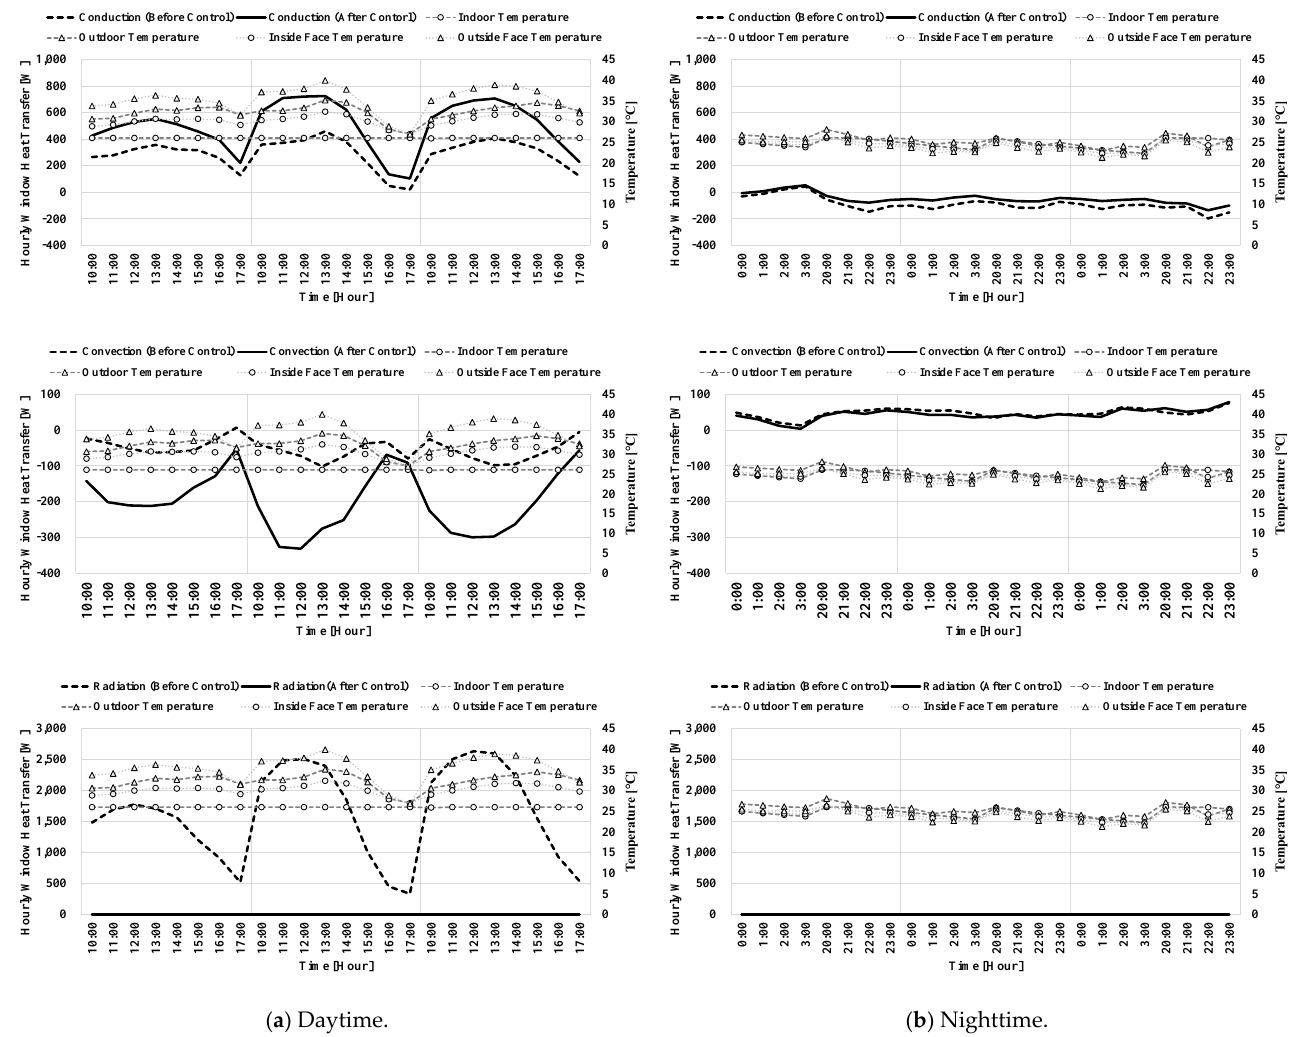
Figure 9. Hourly window heat transfer during the cooling period.